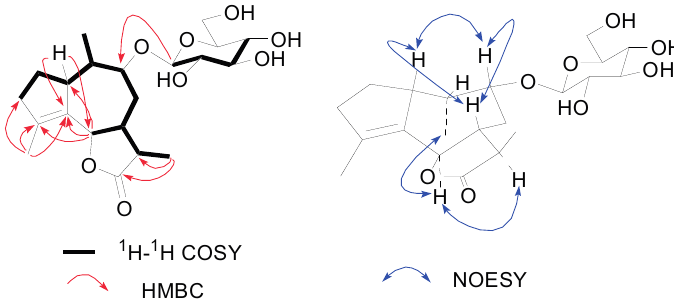
Figure 3. Key 1 H- 1 H COSY, HMBC and NOESY correlations of 2